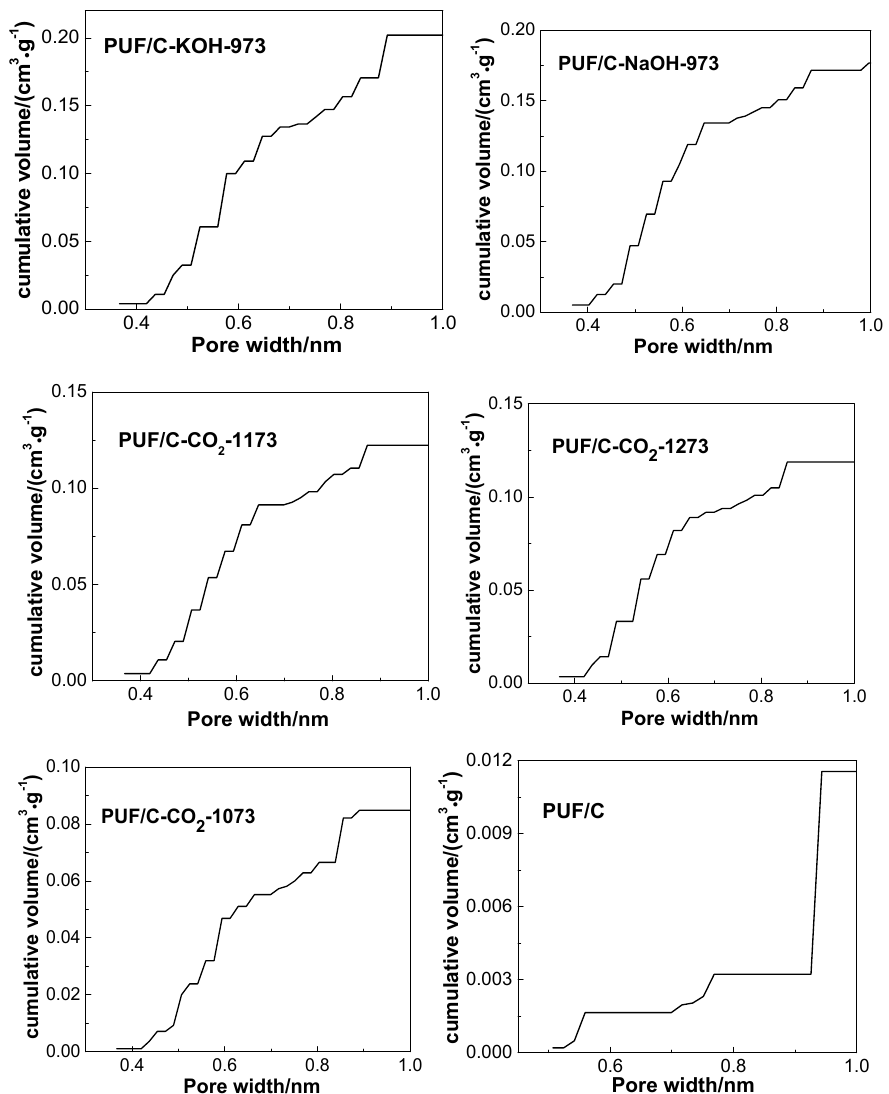
Figure 8. Cumulative volumes of ultramicropores ( ≤ 1 nm) calculated by the nonlocal